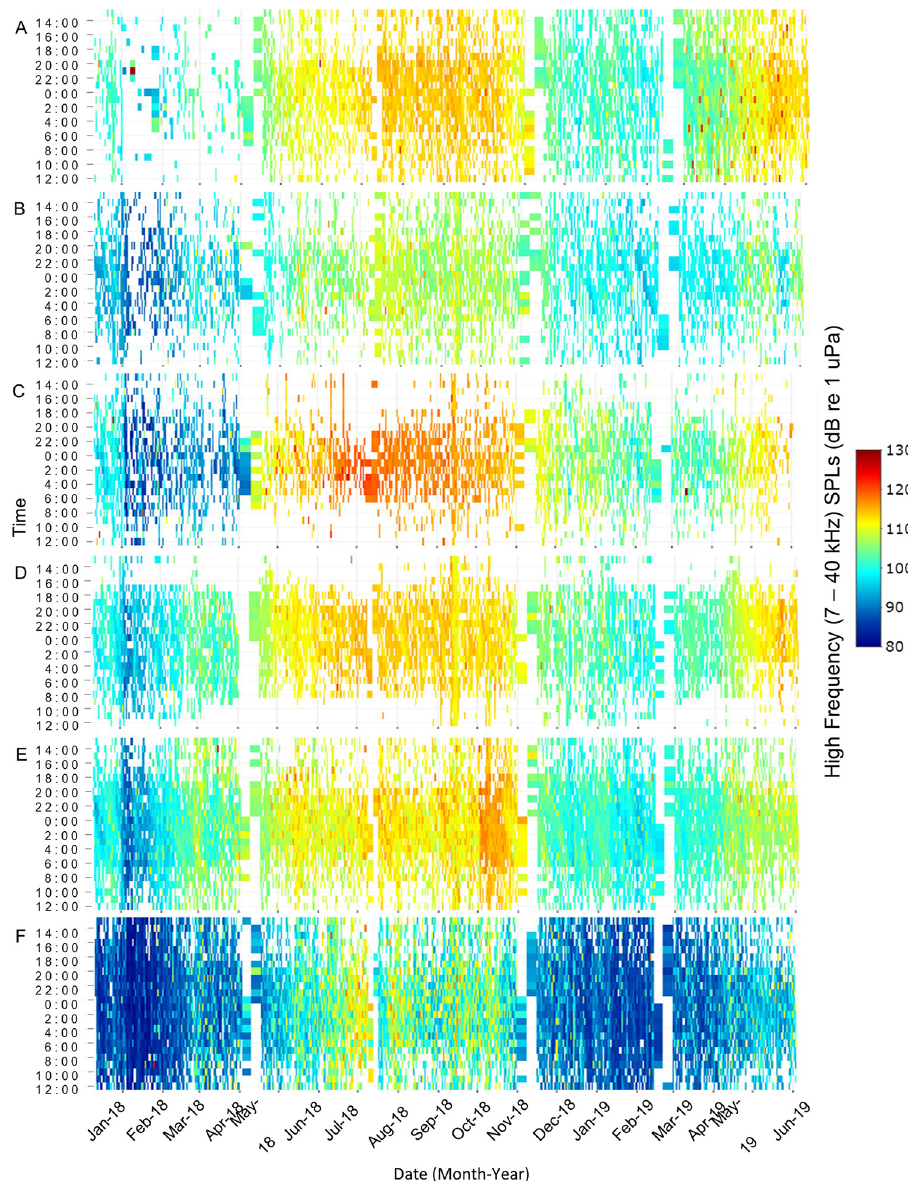
Fig 5. High frequency, sound pressure level heat map—noise excluded. Spatial and temporal patterns of high frequency received sound pressure levels (7–40 kHz) with all detections of noise excluded at (A) Wando River, (B) Drum Island, (C) SC Aquarium, (D) Fort Sumter, (E) Ashley River, and (F) Citadel stations. Two minutes of acoustic data from each hour were manually reviewed. Time is shown between noon and noon the next day. White spaces represent gaps in the data due to maintenance of equipment between deployments or removal of a recording from the dataset due to the detection of anthropogenic noise.